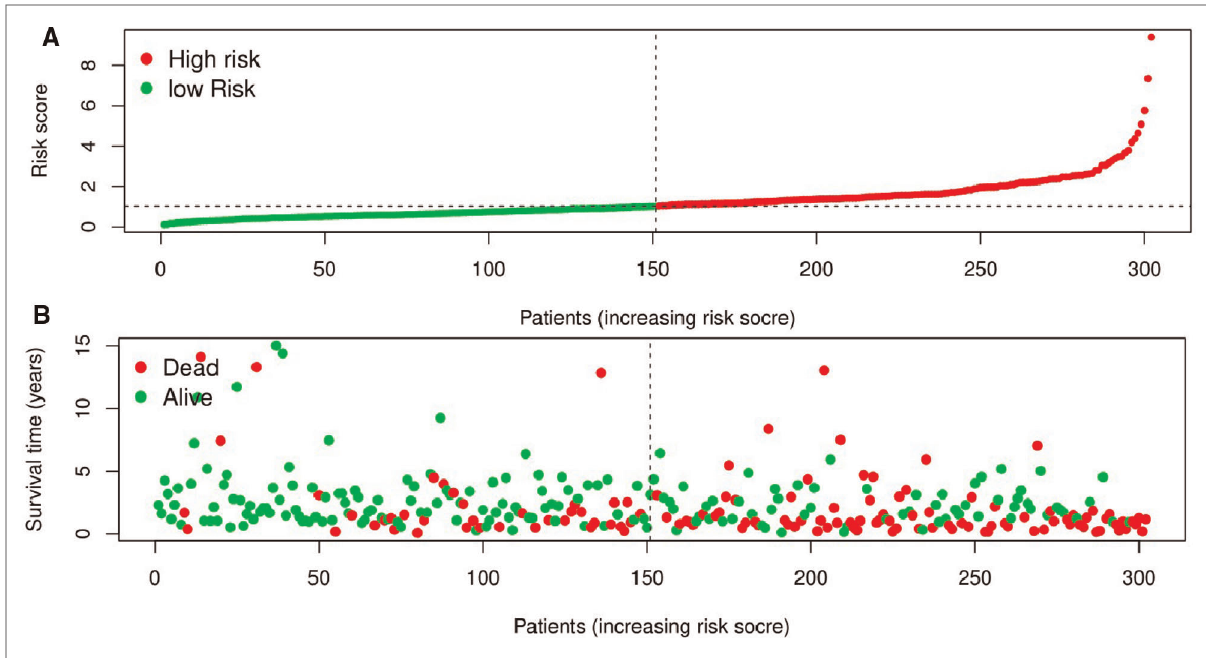
FIGURE 4 Prognostic value of the eight pyroptosis-related lncRNAs signature in patients with oral squamous cell carcinoma. ( A ) According to the median risk score, patients were divided into low-risk group and high-risk group. And the risk distribution diagram of patients wew arranged by risk score. ( B ) The survival status distribution shows that the mortality rate of patients in the high-risk group is signi fi cantly higher than that of patients in the low-risk group, and the survival time is shorter.